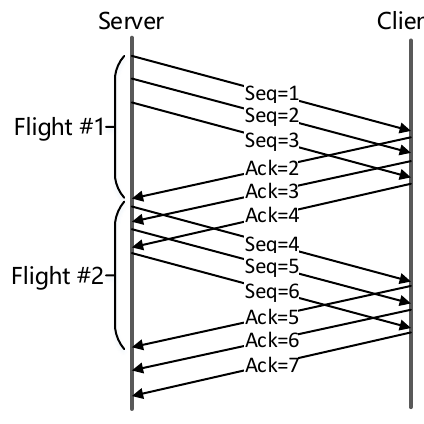
Figure 1. Group packets into flights.